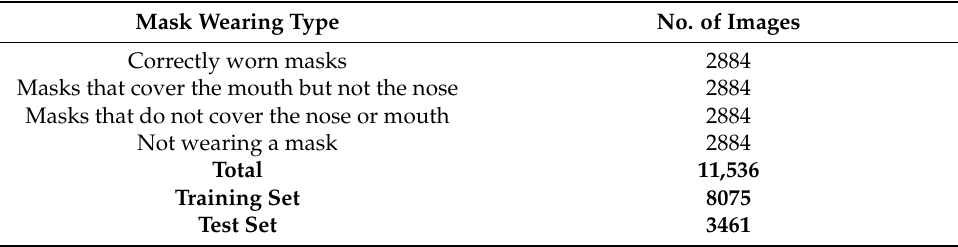
Figure 2. Sample of the unseen images in which persons are wearing a facemask in four different ways. ( a ) Images of a female covering her face using a facemask, and ( b ) images of a male covering his face using a facemask. Table 2. A summary of the dataset used for facemask detection research.